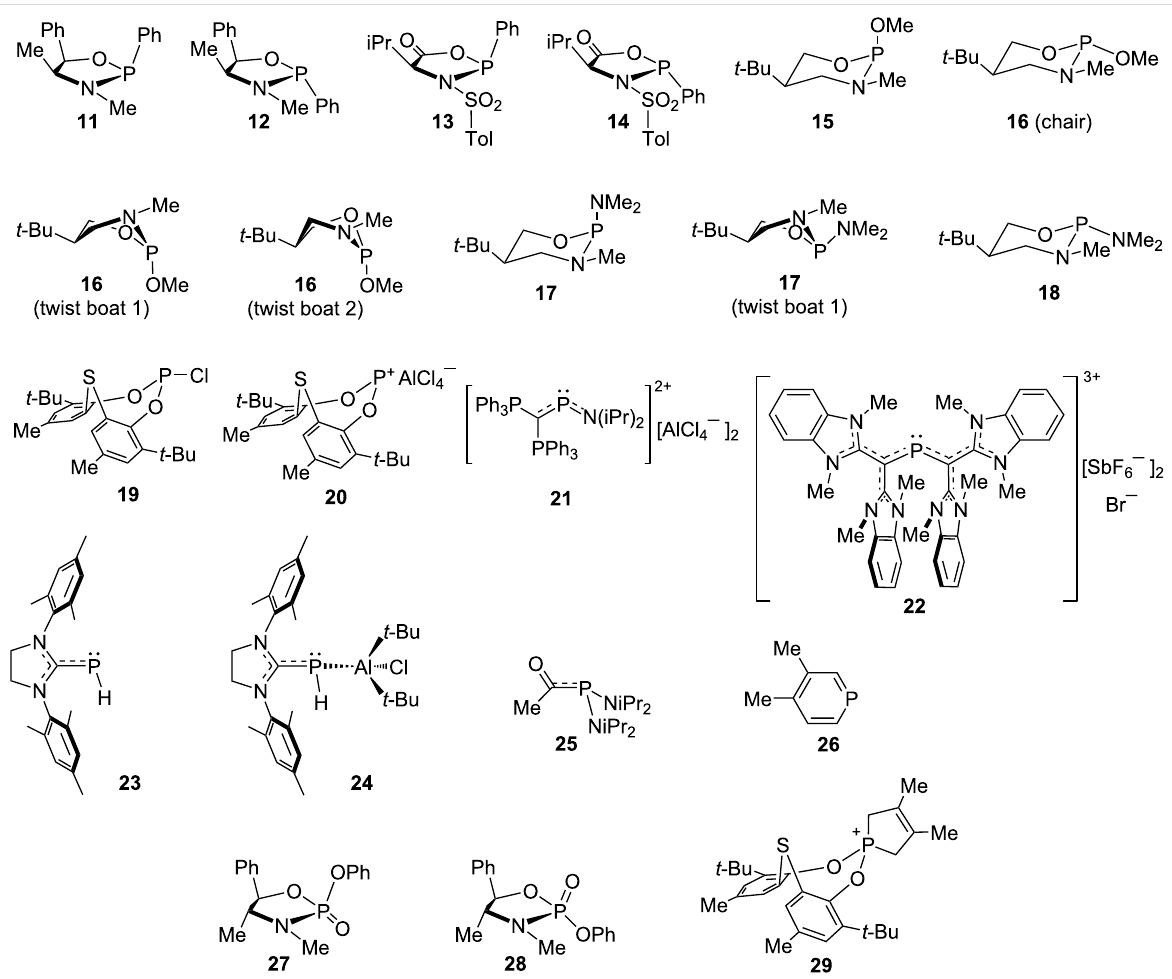
stereoisomers (i.e., 11 / 12 , 13 / 14 , 15 / 16 , 17 / 18 , and 27 / 28 ), the correct order of calculated upfield and downfield shifts was ob- served, although the calculated difference between the cis and trans isomers tended to be larger than the experimental differ- ence for the trivalent compounds. Conformational differences play a role here, particularly for the six-membered rings in com- pounds 15 – 18 , where the twist boat conformations can be the major isomers in solution [74] (see Table 3 footnotes and Sup- porting Information File 1 for details), although care was taken to find all important conformations to be included in the NMR